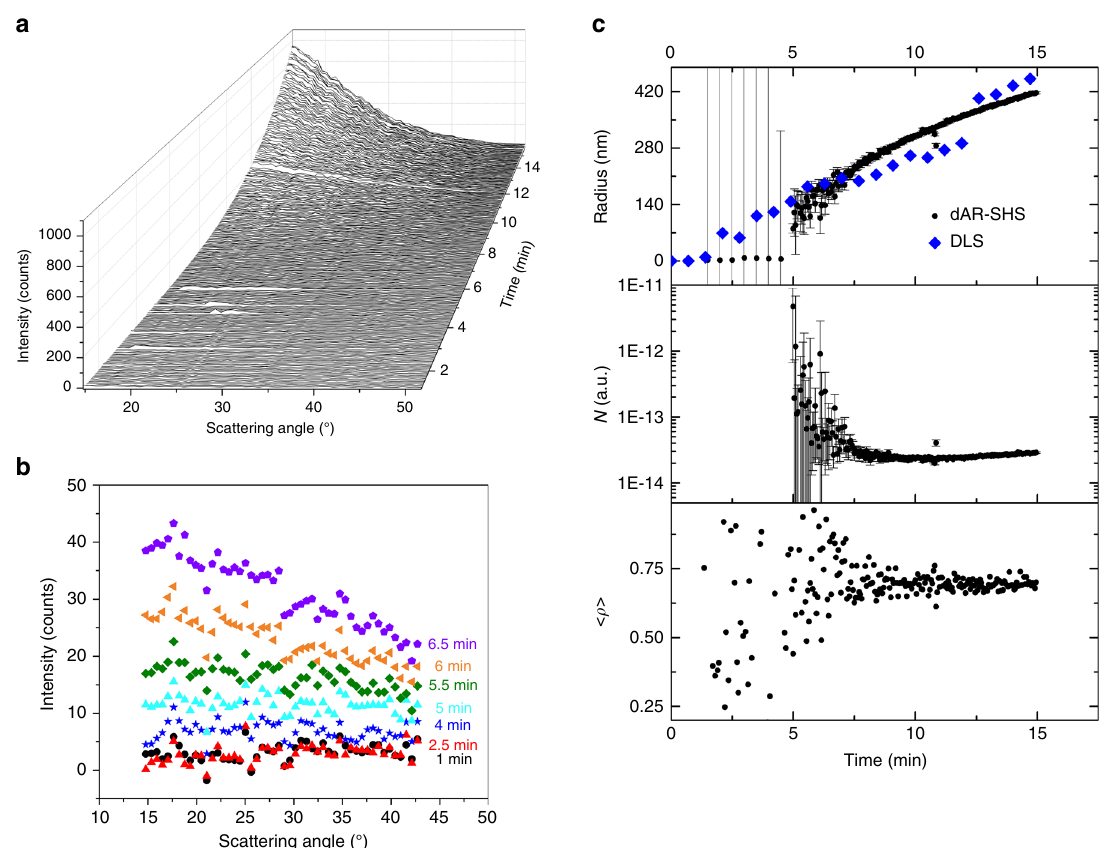
Fig. 3 Dynamic angle-resolved second harmonic scattering during crystal growth of ZIF-8. a Dynamic angle-resolved second harmonic scattering (dAR- SHS) patterns as function of time. During the course of the measurement AR-SHS patterns become more intense and increasingly forward directed as expected for growing particles. b AR-SHS patterns at different times during the earliest stages. The curves shown are an average over 10 measurements (~30 s), c Radius, number of particles (N) and depolarization extracted from the data presented in Fig. 3a by nonlinear regression towards the nonlinear Rayleigh-Gans-Debye model for monodisperse spheres. The standard errors for the derived parameters are estimated by the OriginPro fi tting software according to the Error Propagation formula. In the fi rst panel data obtained from a dynamic light scattering experiment (DLS) are shown in blue in Fig. 3c. The depolarization approaches 0.64, as expected for the symmetry group of ZIF-8 (T d